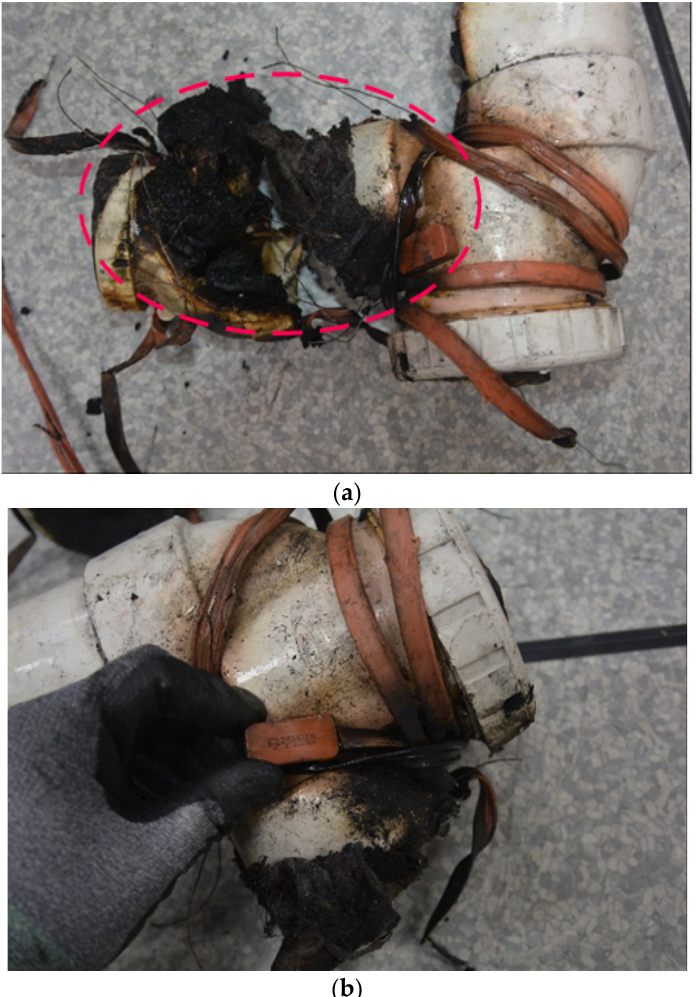
Figure 8. Fire caused by heating cables irregularly wrapped in multiple layers around a water ser- vice pipe. ( a ) Case 3—Fire site ➀ . ( b ) Case 3—Fire site ➁ . pipe. ( a ) Case 3—Fire site 1 (cid:13) . ( b ) Case 3—Fire site 2 (cid:13)